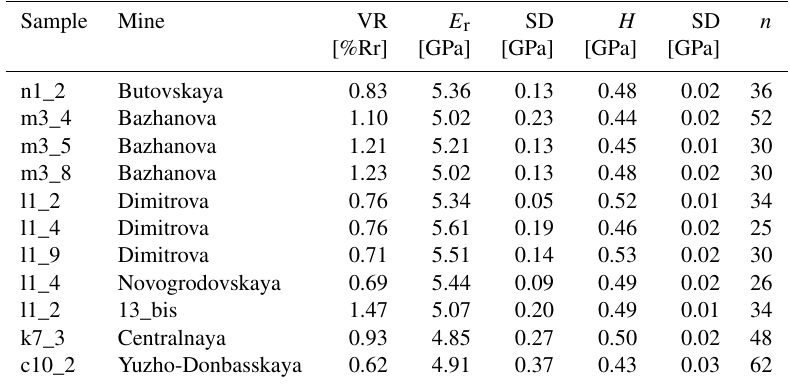
Table 2. Obtained H and E r averages for vitrinite, including standard deviations (SD) calculated from the respective number of measurements ( n ). Sample Mine VR